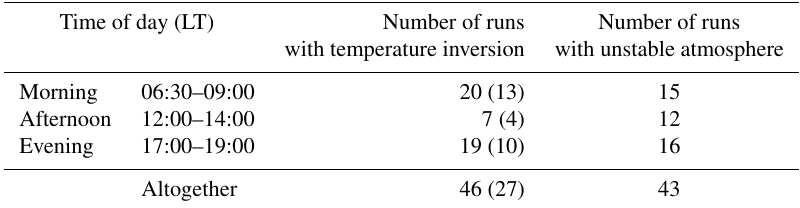
Table 3. Number of runs in winter 2017–2018 classified as runs during temperature inversion and runs during unstable atmosphere. The number of runs with strong temperature inversion is shown in brackets. Time of day (LT)